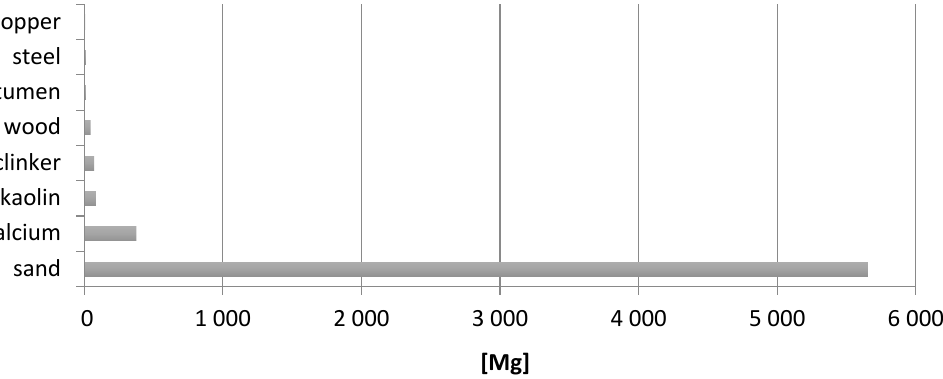
Figure 4. Materials with the highest mass share used during the construction of the research object [own study based on the investor’s data].